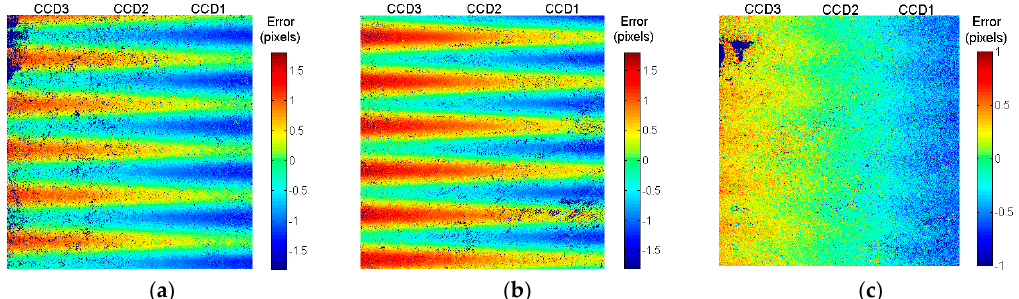
Figure 4. Parallax images between B1 and B2 across the track of ( a ) Scene A, ( b ) Scene B, and ( c ) Scene C.